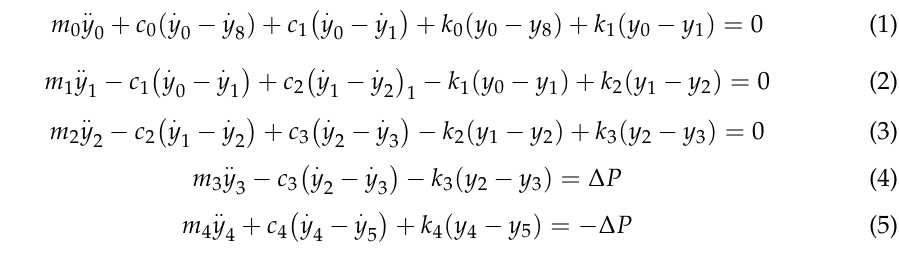
Figure 2. Mechanical structure diagram and vibration model diagram of vertical system of rolling mill: ( a ) three-dimensional model diagram of mechanical structure of cold rolling mill; ( b ) equivalent vertical vibration model diagram of cold rolling mill .